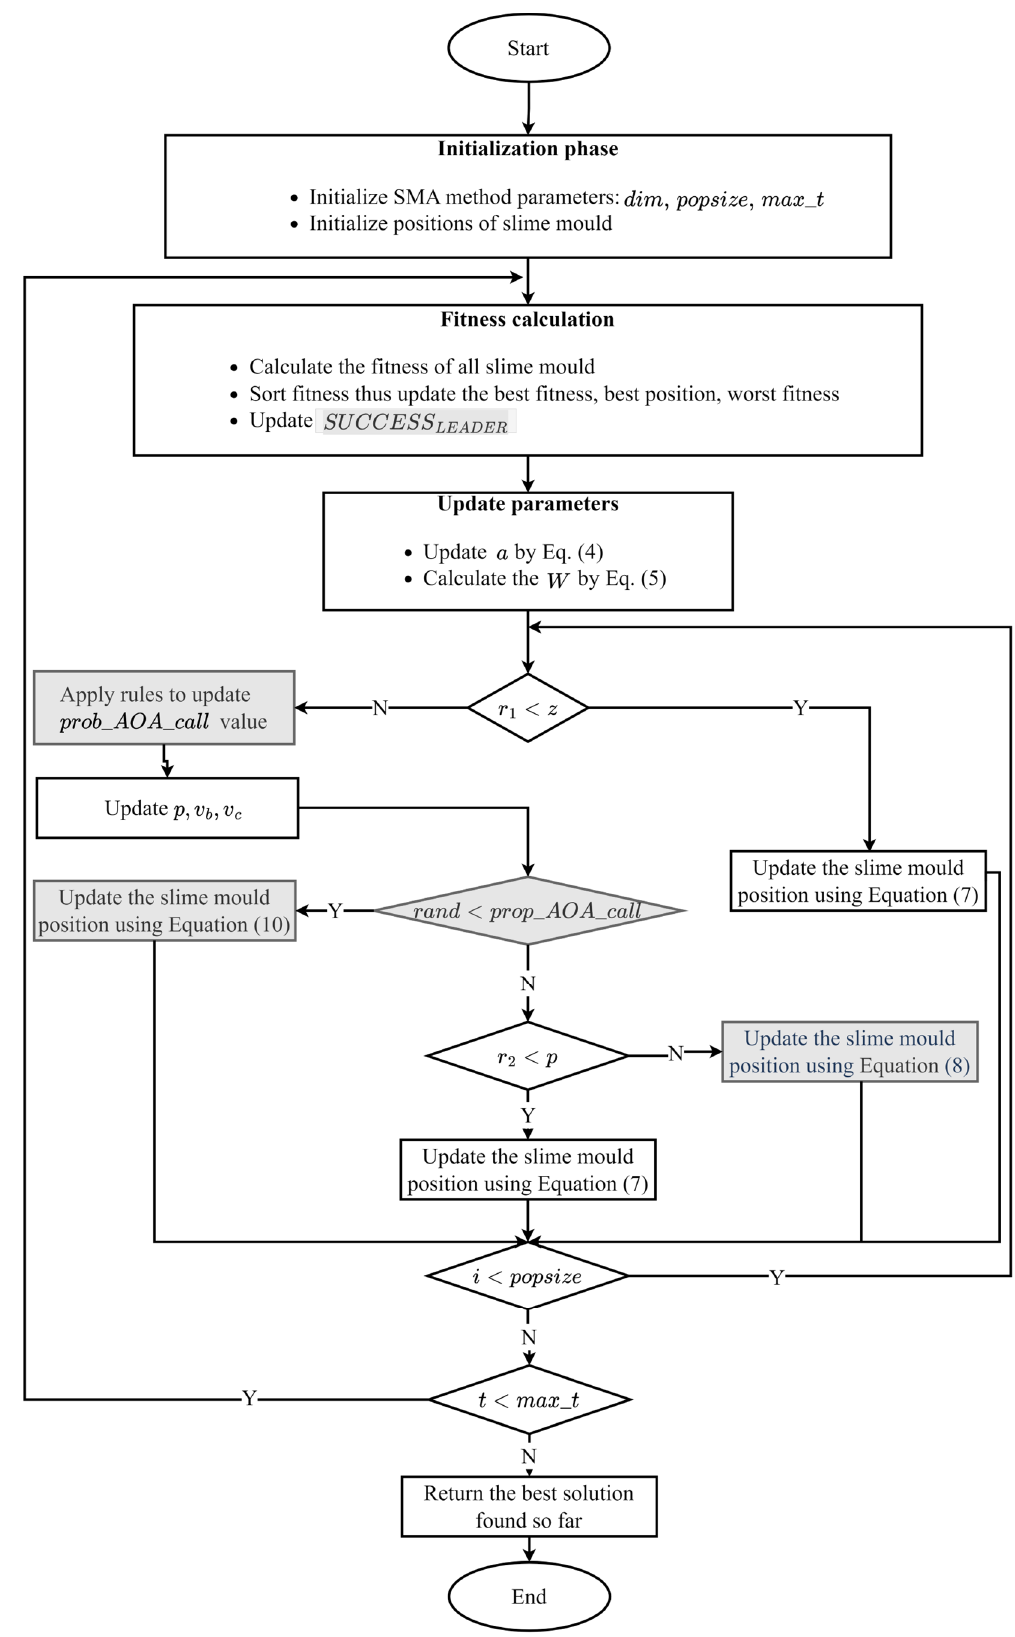
Figure 6. Flow chart of the proposed method.